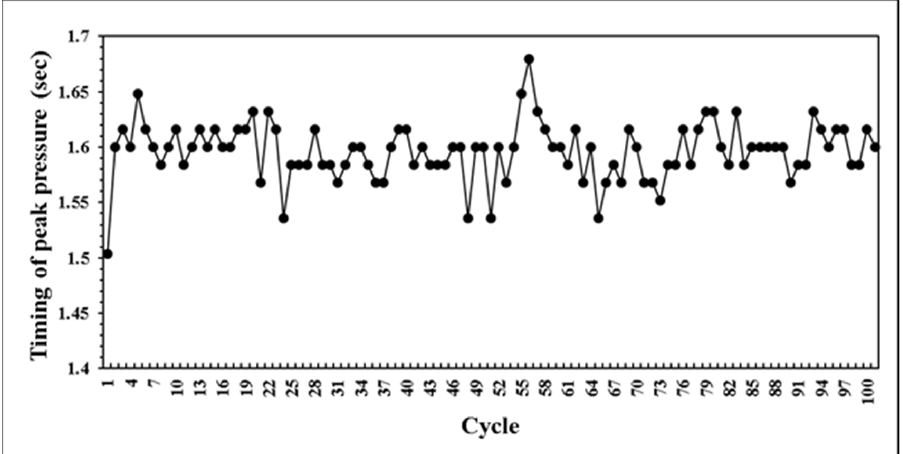
Figure 24. Distribution of part weight in experiment. 4.5. Performance Comparison between with and without System To verify performance of adaptive control system, compare the 100-cycle-running results with and without the control system in Figure 25. The respective analysis results are shown in Tables 4 and 5. These results imply that the system can significantly stabilize the injection molding and maintain the part weight consistency. The variation of part weight decreased from 0.25% to 0.14%. Figure 25. Performance comparison between using system and no system.